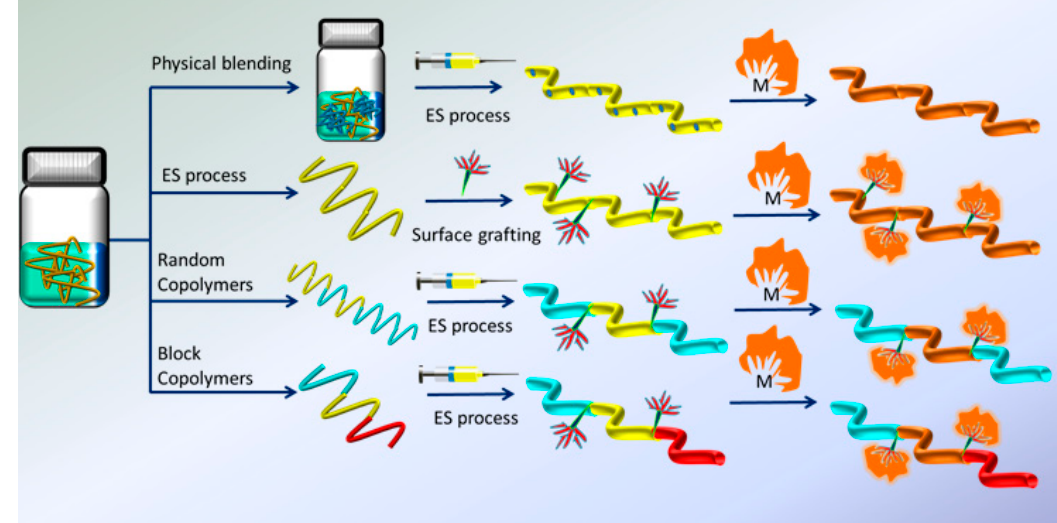
Figure 1. Electrospinning (ES) based optical sensor developed with di ff erent synthetic strategies and device fabrication process.